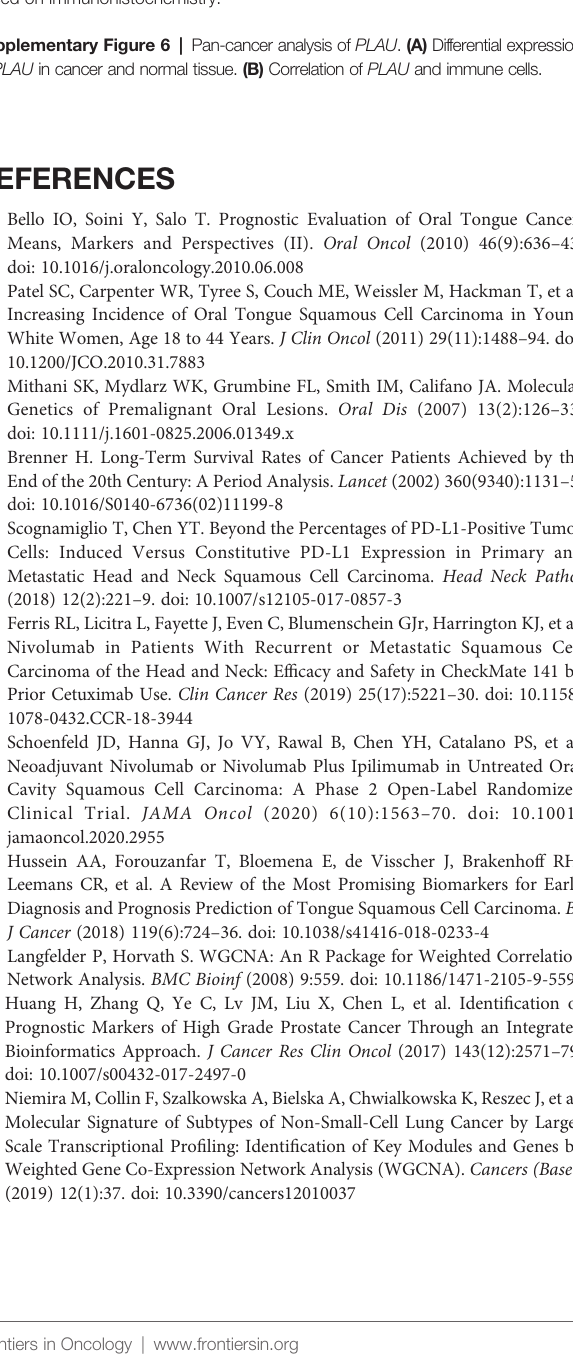
Supplementary Table 1 | Cox analysis of prognostic genes in TCGA. Supplementary Table 2 | The different expressed genes in TCGA in comparison of cancer and normal tissue. Supplementary Table 3 | The interacted genes from Cox analysis and the comparison of cancer and normal tissue. Supplementary Table 4 | Cox analysis of prognostic genes in GSE65858.